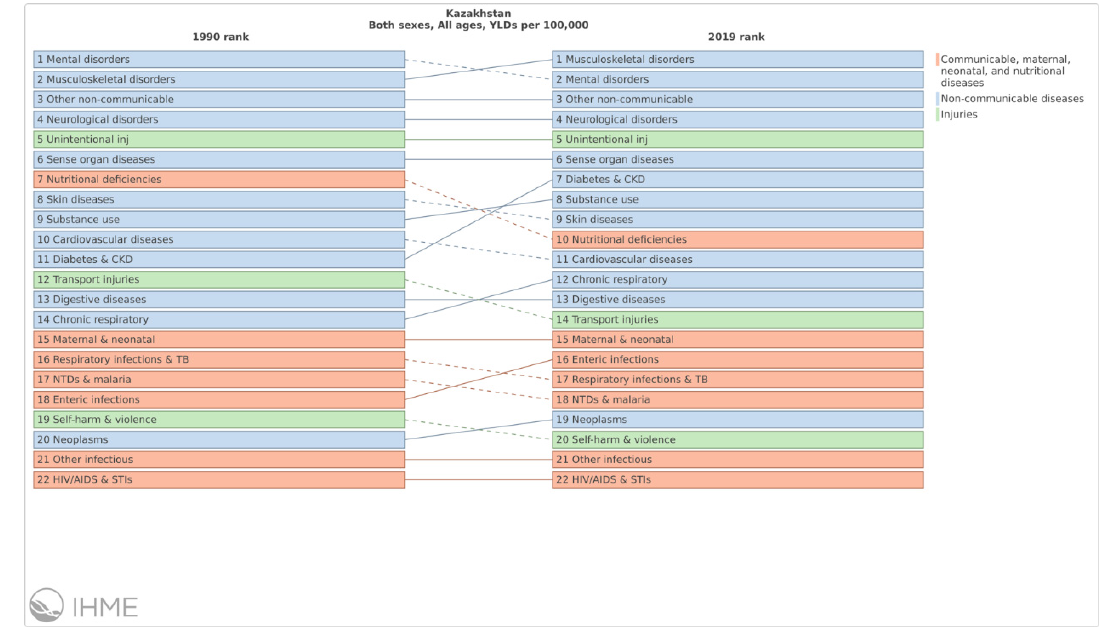
Figure 3. Leading causes of years lived with disability in 1990 and 2019, all ages. Changes signal the increasing impact that obesity and diabetes have on population health. Source: IHME, https://vizhub.healthdata.org/gbd-compare/ (accessed on 22 November 2021).